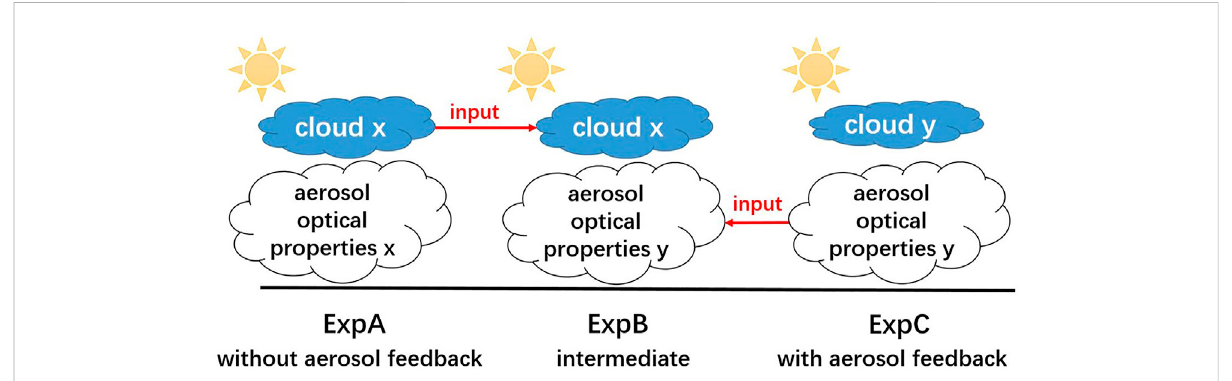
FIGURE 2 Schematic illustration of the experiment design in isolating aerosol direct and semi-direct effect using WRF-Chem. ExpA is conducted without aerosol feedback, ExpC is conducted with aerosol feedback. While in ExpB, cloud properties are imported from ExpA and aerosol optical properties areimportedfromExpC.Therefore,theonlydifferencesbetweenExpAandExpBaretheaerosolopticalproperties,whichrepresentthedirecteffect. The only differences between ExpB and ExpC are the cloud properties, which represent the semi-direct